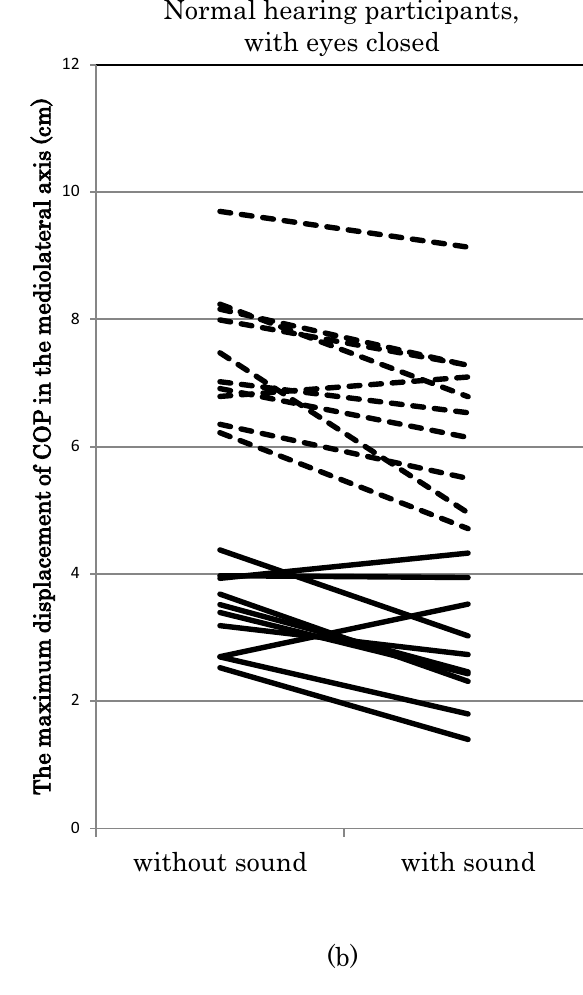
Fig 1. The maximum displacement of the center of pressure in the mediolateral direction with eyes closed.